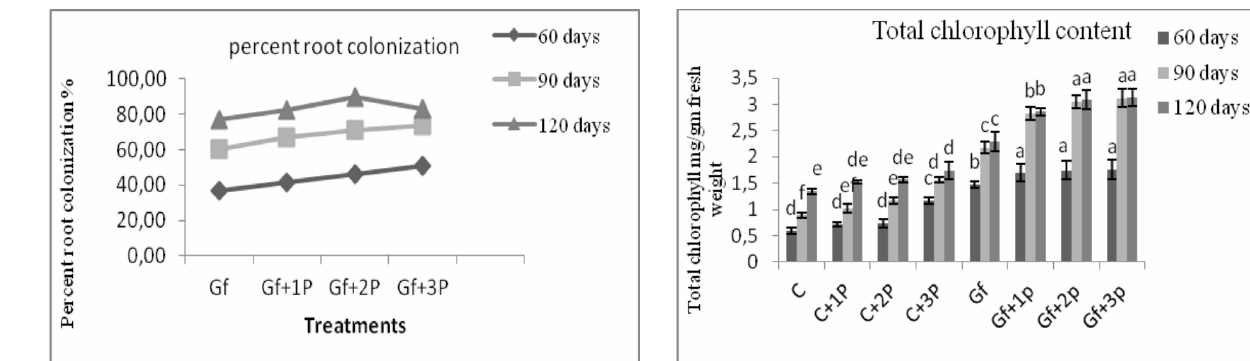
Fig. 2. Total chlorophyll content in Catharanthus roseus L. after 60, 90 and 120 days of AM inoculation